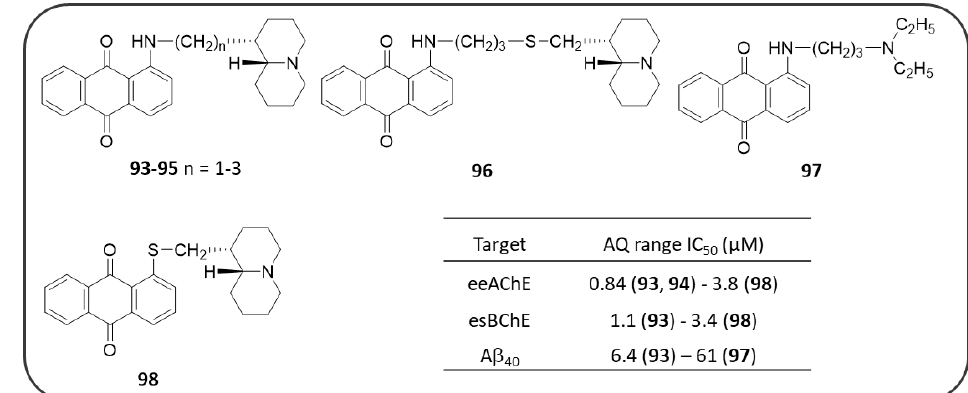
Figure 18. AQ derivatives studied by Sparatore et al. as ChEs and Aβ aggregation inhibitors. Wang, J. et al. recently described the potential activity of a series of synthetic azaanthraquinone compounds (series 99 and 100 , Figure 19) for the treatment of AD, where different substitutions in position 6 of the scaffold were explored [171]. These compounds were found to interfere with different key target points of AD neurode- generation. They showed the ability to block A β 42 aggregation and secretion, and par- ticularly six compounds, bearing the piperidine or tetrahydroisoquinoline or pyrroli- dine rings, shared a potency trend comparable to the reference compound curcumin (% inhibition at 100 µ M = 48.1% ± 2.7 µ M). Moreover, they displayed anti-inflammatory properties by suppressing NO and iNOS production, and by modulating the synthesis of cytokines. Meanwhile, these azaanthraquinones proved to be AChE-preferring in- hibitors with respect to BChE with micromolar IC 50s (the most active compounds were the piperidine derivatives 99a and 100a : AChE IC 50 = 1.08 and 1.12 µ M, respectively), and to permeate the blood-brain barrier in vitro. Other promising properties included a low degree of toxicity and a neuroprotective efficacy against H 2 O 2 -induced neurotoxicity towards SH-SY5Y neuroblastoma cells [171].